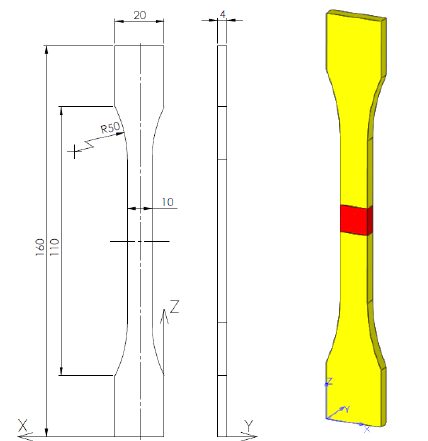
Figure 1: Tensile test specimen dimensions, building orientation and 3D scanned area